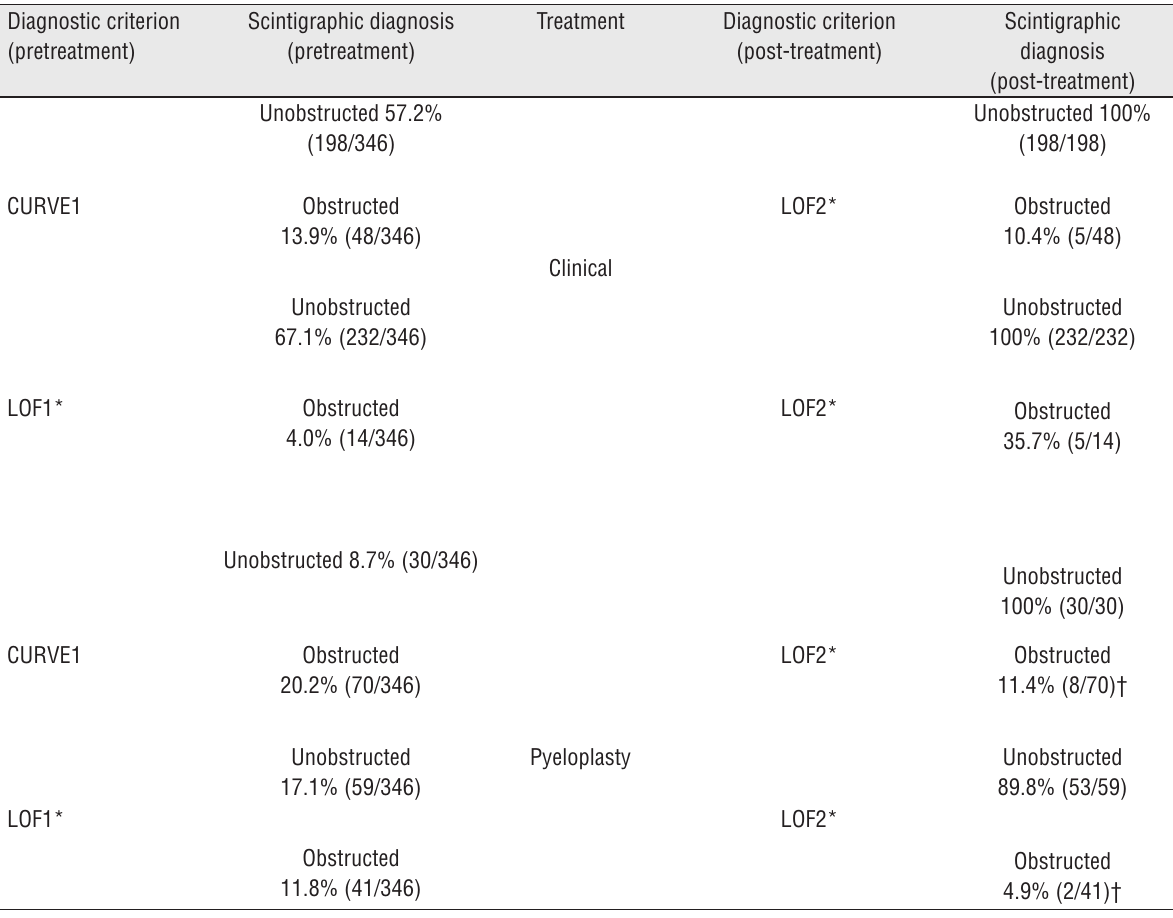
cURvE1: renal curves in the first scan. LOf1 and 2: late output fraction in the first and second scans.